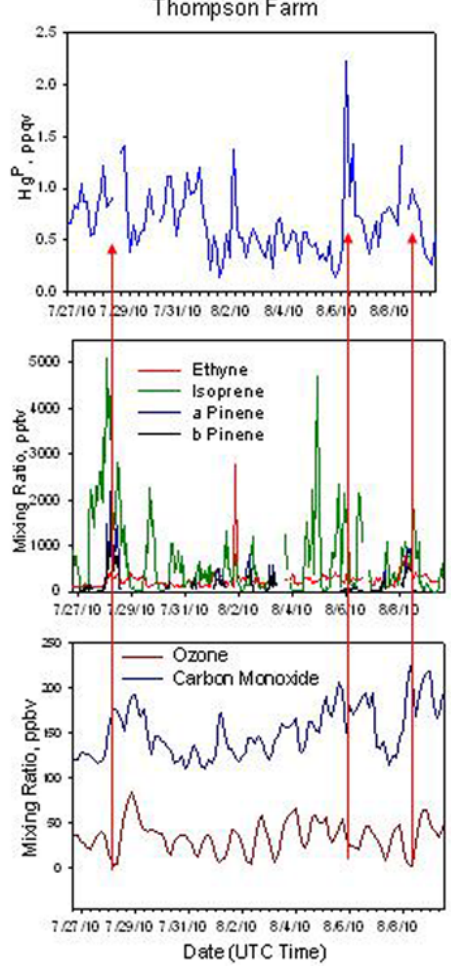
Fig. 9. Hydrocarbon data correlates with Hg P peaks shown for Thompson Farm. Top Panel: bulk filter data for Thompson Farm during summer 2010. Middle Panel: hydrocarbon data from GC showing ethyne (red), isoprene (green), α -pinene (blue), and β - pinene (black) at one hour time resolution. Bottom Panel: ozone (red) and carbon monoxide (blue) data from Thompson Farm at one hour time resolution. Based on CO and C 2 H 2 , this is a relatively clean time period. Results show that peaks in hydrocarbon data and carbon monoxide indicate an increase in Hg P to the region. It also shows that Hg P has many sources, as shown by the elevation in some substances does not always indicate an elevation in Hg P